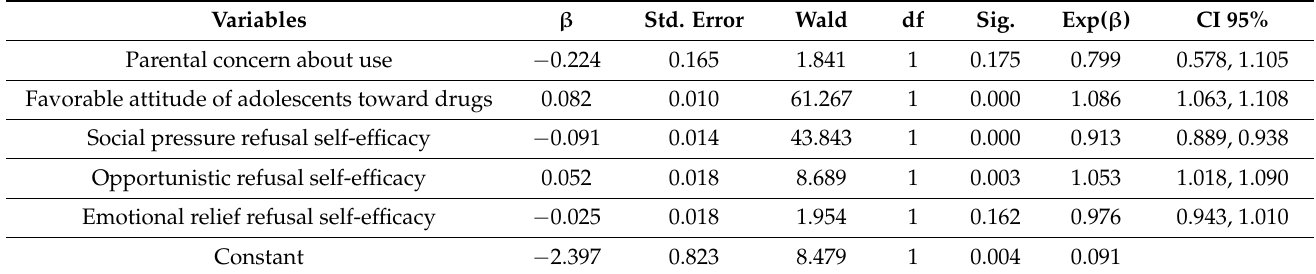
Table 7. Results derived from the logistic regression for likelihood of smoking